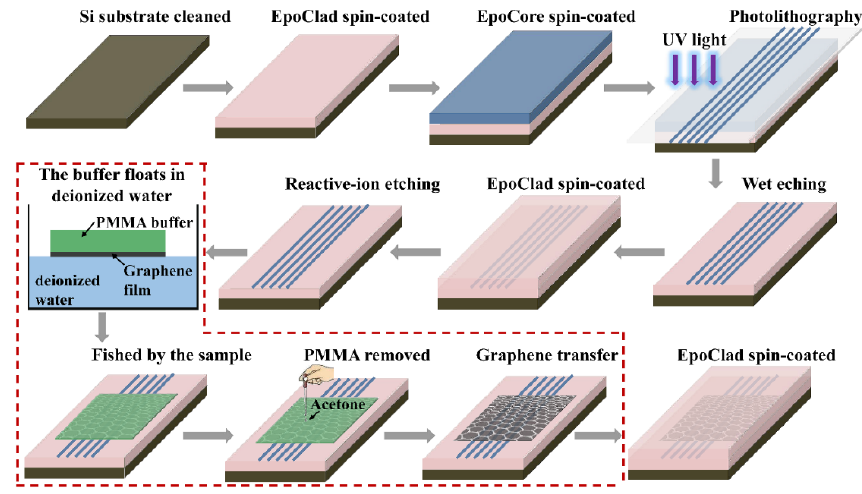
Figure 3. The fabrication process of the polarizer with graphene film placed on the surface of core layer.